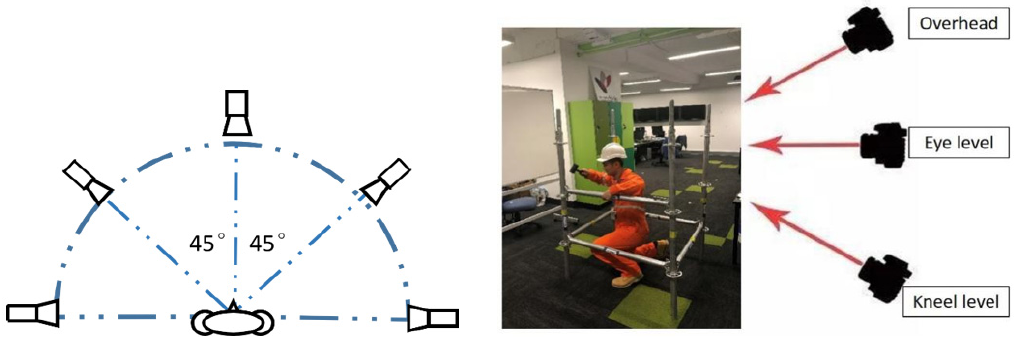
Figure 9. Experiment settings: the camera shot angle was set at three height levels: kneel level, eye level and overhead level and the horizontal camera angles range from the frontal angle, and three-quarter front angle to profile angle.